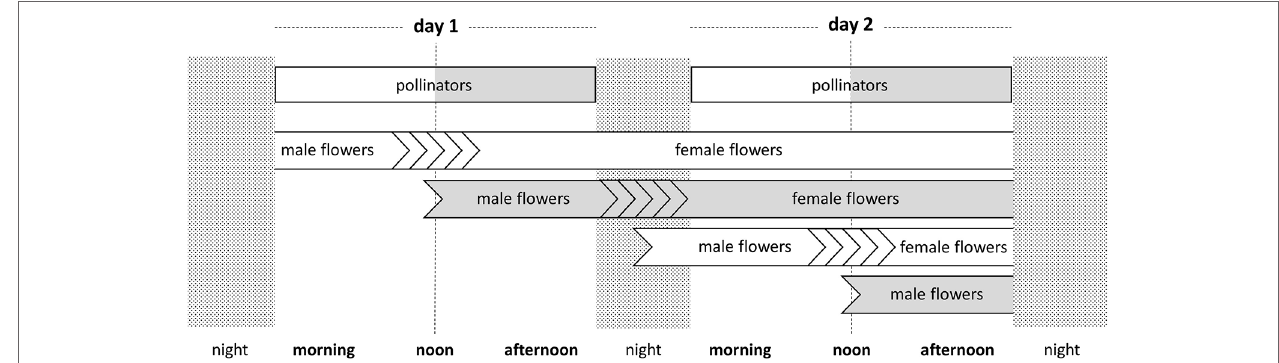
FIGURE 2 | Time course of the flower sex phases in the two protandrous flowering morphs over two consecutive days, as used in the probabilistic model. The modeled time unit is 48 h, the blooming duration of a single flower. The timing of visits by morning-active and afternoon-active pollinators, as incorporated into the model, is indicated. Open bars represent the Early flowering morph and morning pollinators. Grey bars represent the Late flowering morph and afternoon pollinators. Multiple chevrons represent time variation intransitions from male- to female-phase. The events in this 48-hour time unit are representative of the whole flowering